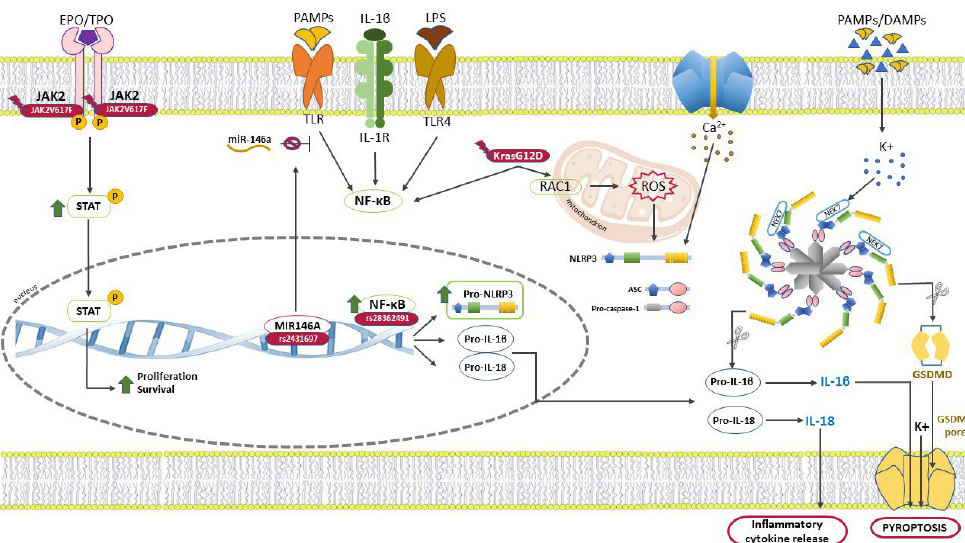
Figure 2. MPN is accelerated by the overactive inflammatory STAT and NF- κB1 signaling pathways. The MPN patients’ BM cells with the JAK2V617F mutation showed a high expression of the NLRP3, NF- κB1, IL -1 β , IL-18, and CARD8 genes. The NLRP3 inflammasome priming step was activated by the PAMPs, LPS and cytokines through the NF- κB1 pathway. In the nucleus, this molecule pro- moted the transcription of NLRP3 , IL-1 β and IL-18 . The NF- κB -94 ins/del ATGG (rs28362491) poly- morphism was related to the enhancement of NF- κB1 and the NLRP3 expression. The inflam- masome assembly (activation step) was brought on by a Ca2+ efflux and the PAMPs and DAMPs through a K+ efflux increase. NLRP3 combined with the ASC and caspase-1 proteins to form the spike complex. The spike cleaved pro-IL-1 β , pro-IL-18 and GSDMD into their active form. GSDMD pore forming, along with the K+ efflux and IL-1 β protein, gave rise to pyroptosis. The KrasG12D mutation enhanced the NLRP3/IL-1 β axis and also increased the NLRP3 activation, triggering the RAC1/ROS signaling. Normally, the miR-146a protein negatively regulates the innate immunologi- cal and inflammatory responses. Otherwise, the expression of the miR-146a rs2431697 TT genotype was frequently found in MPNs patients and was linked to an elevated expression of NLRP3, NF- κB1, and IL-1 β inflammatory genes. NLRP3: nucleotide-binding domain-like receptor protein 3; EPO: erythropoietin; TPO: thrombopoietin; PAMPs: pathogen-associated molecular patterns; DAMPs: danger-associated molecular patterns; LPS: lipopolysaccharide; TLR: toll-like receptor; GSDMD: gasdermin-D. 5. Novel Therapeutic Approaches There are limits to the JAK inhibitors’ activity despite the radical changes they have brought to the MPN landscape and their crucial part in the treatment of MF [109]. Several intriguing new drugs such as BET inhibitors (pelabresib), BcL-xl inhibitors (navitoclax), and PI3K inhibitors (parsaclisib), with different mechanisms of action beyond the JAK- STAT pathway, are in advanced clinical development. These can be used alone or with ruxolitinib, a targeted JAK2 inhibitor [110,111]. In the preclinical investigations, novel im- munotherapies have been investigated, including neoepitope-directed vaccinations and monoclonal antibodies against mutant-driven MPNs [112,113]. The JAK2-NLRP3 axis has been studied in vitro in autoimmune inflammatory diseases in which JAK modulates the myelination/demyelination balance in the neurons, at least through the NLRP3-mediated pathways. The ruxolitinib-inhibited NLRP3 expression, phosphorylation of JAK2, and IL- 1β are released, induced by the thymic stromal lymphopoietin receptor [114]. Zhu et al. demonstrated that the JAK2 inhibition through ruxolitinib administration reduces the NLRP3 inflammasome activation through the JAK2/STAT3 pathway, to improve the is- chemic stroke damage and neuroinflammation. Ruxolitinib suppresses the production of the NLRP3 inflammasome components and reduces several proinflammatory cytokines [115]. The novel therapeutic agents target various biomolecules from the inflammasome pathway in MDS and AML [116]. Inflammasome targeting therapies can be explored as